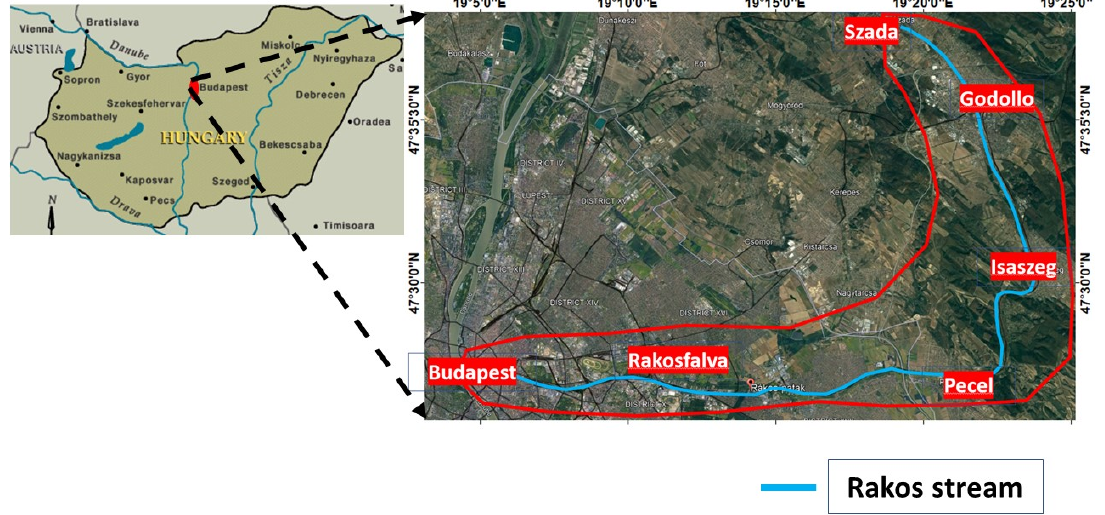
Figure 1. Location map of the studied Rákos stream and positions of the collected water samples.